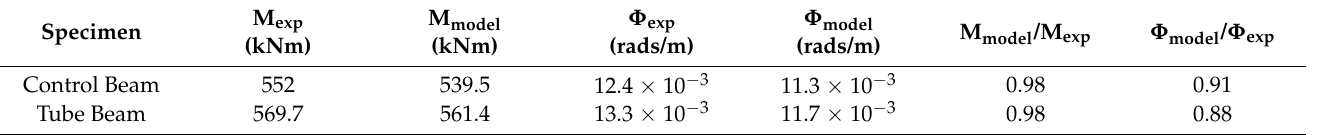
Table 5. Model predictions and experimental values for peak load and curvature at peak load.